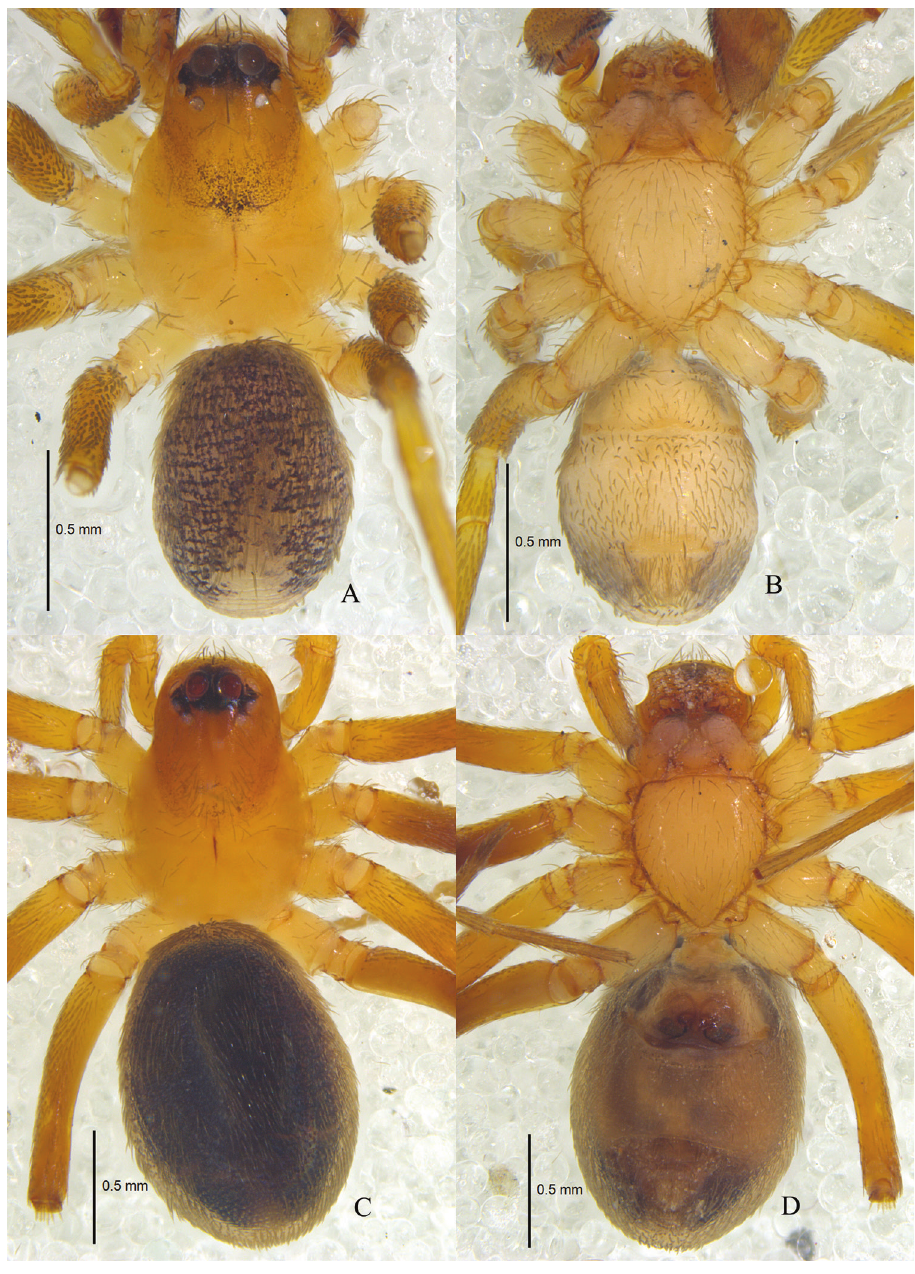
Figure 6. Zodarion ovatum sp. n., male holotype ( A, B ) and female paratype ( C, D ) Habitus ( A, C dorsal view B, D ventral